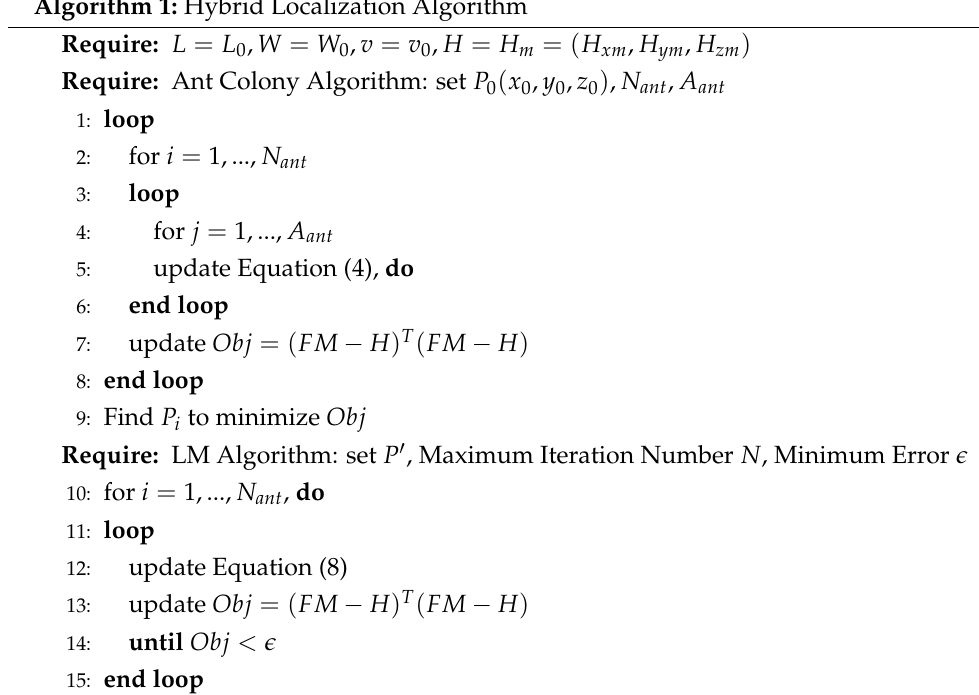
Algorithm 1: Hybrid Localization Algorithm